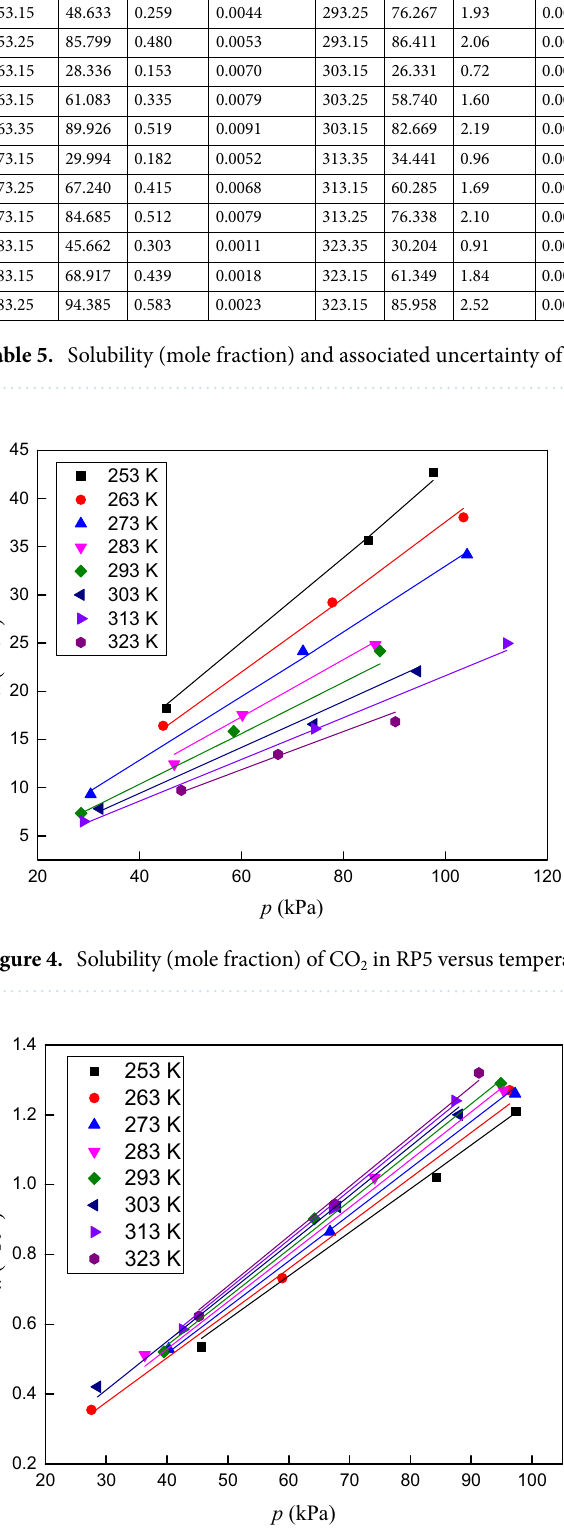
Figure 5. Solubility (mole fraction) of O 2 in RP5 versus temperature and